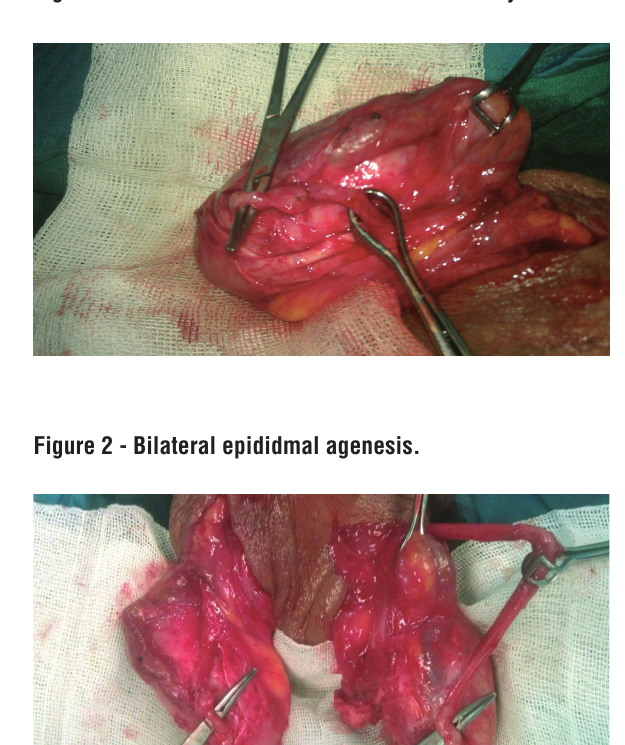
Figure 1 - Vas deference inserted to testis directly.